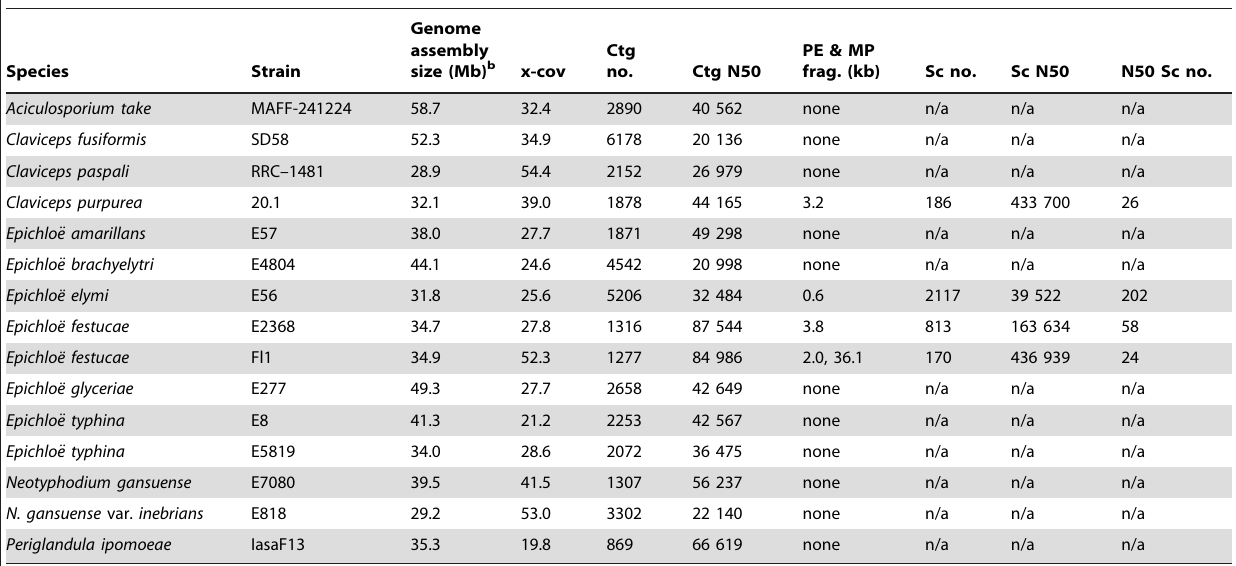
Table 1. Genome sequencing statistics for plant-associated Clavicipitaceae. a